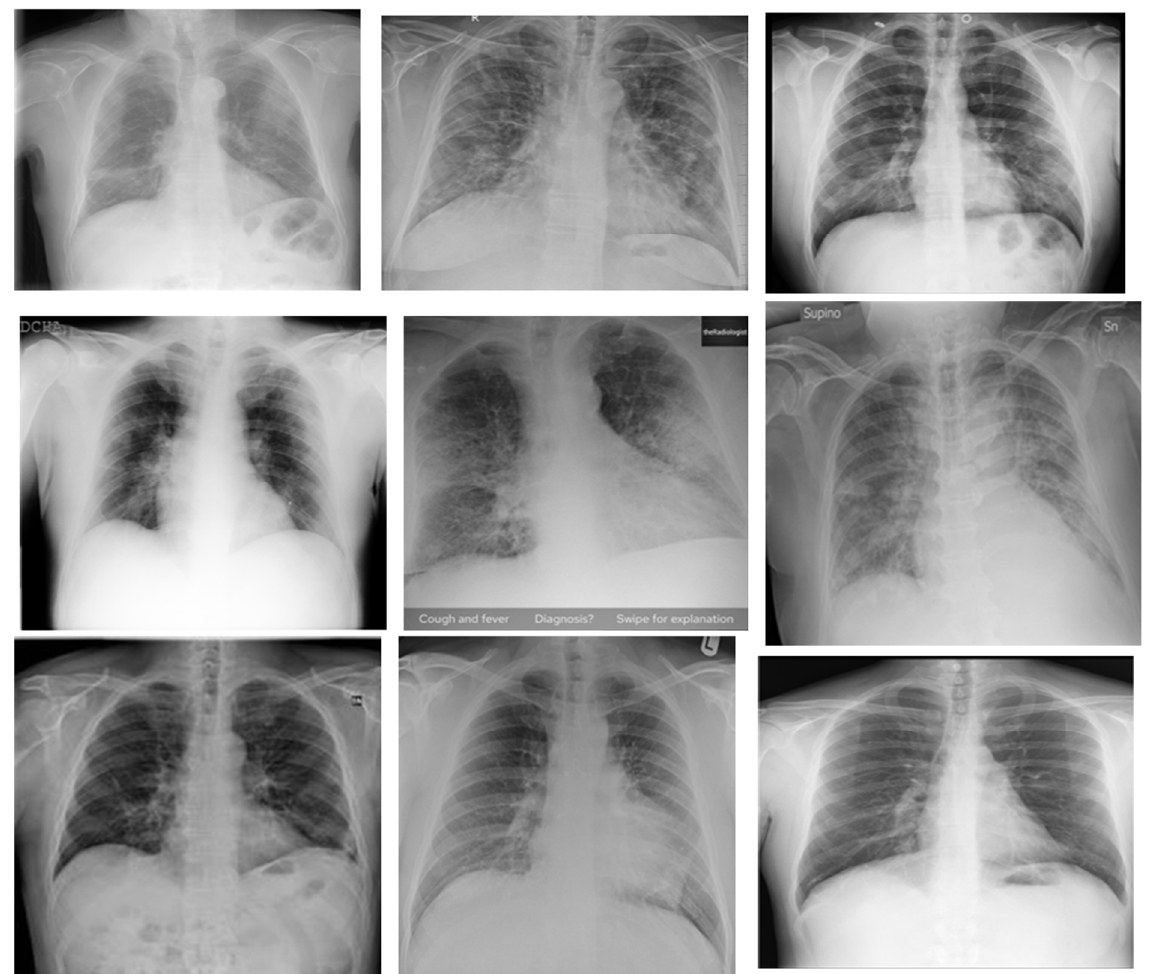
Figure 7. Sample X-ray Image Dataset.